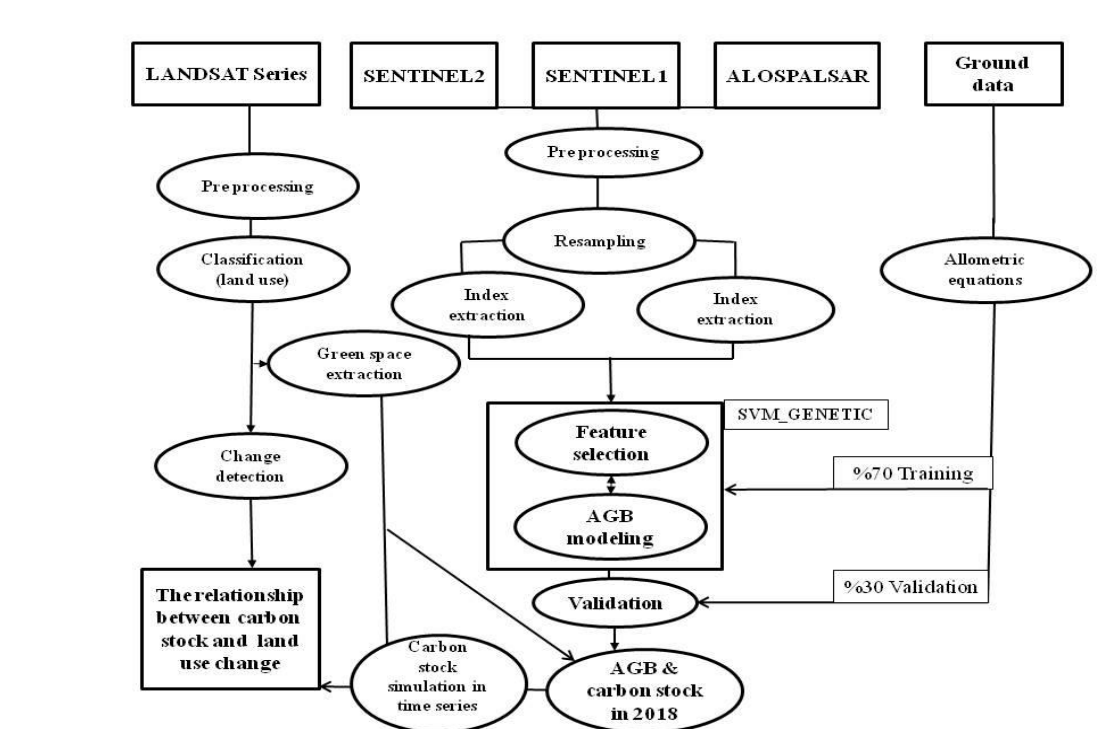
Figure 2. Flowchart of steps used for urban forest carbon stock mapping using optic and radar imagery in this